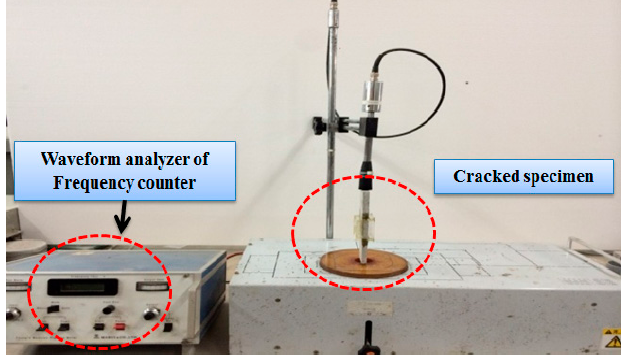
Figure 7. Test machine of relative dynamic modulus of elasticity.